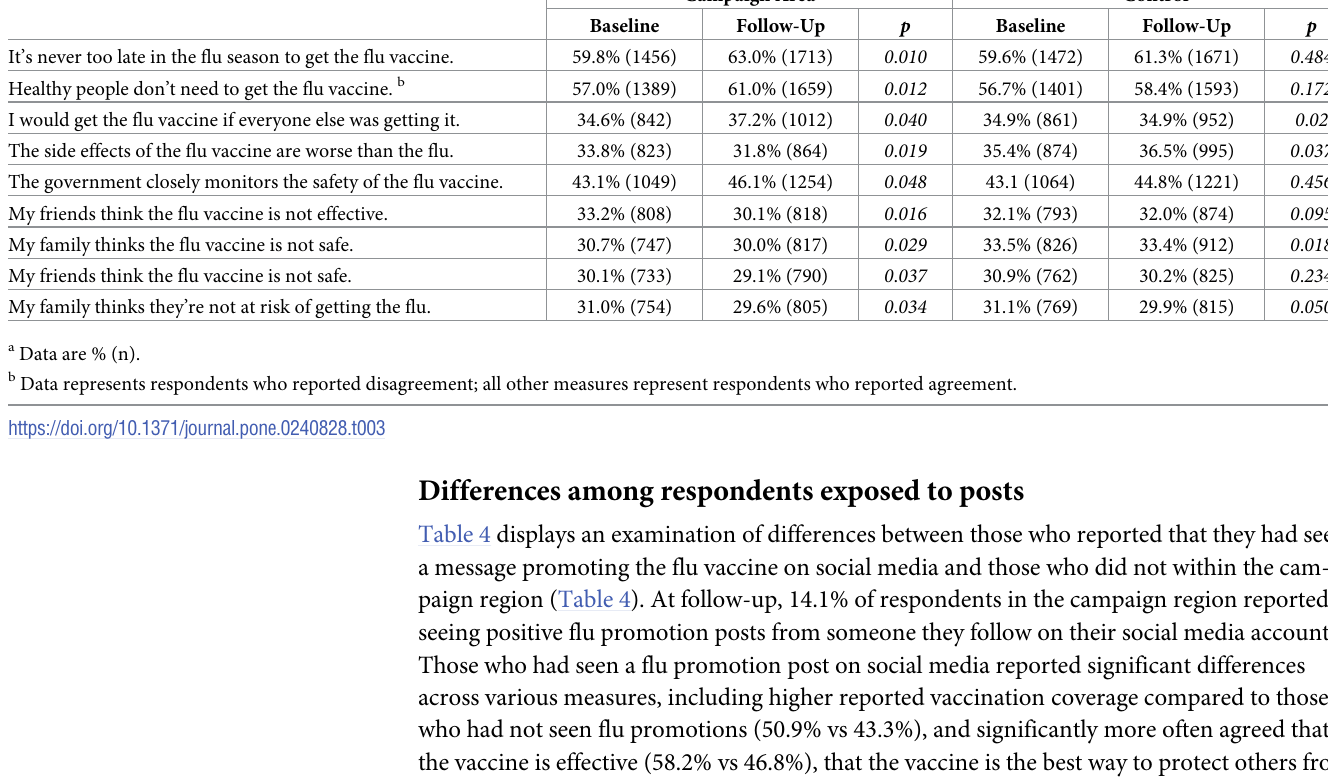
Table 4. Sub-analysis of exposure to flu promotion posts on social media at follow-up a .